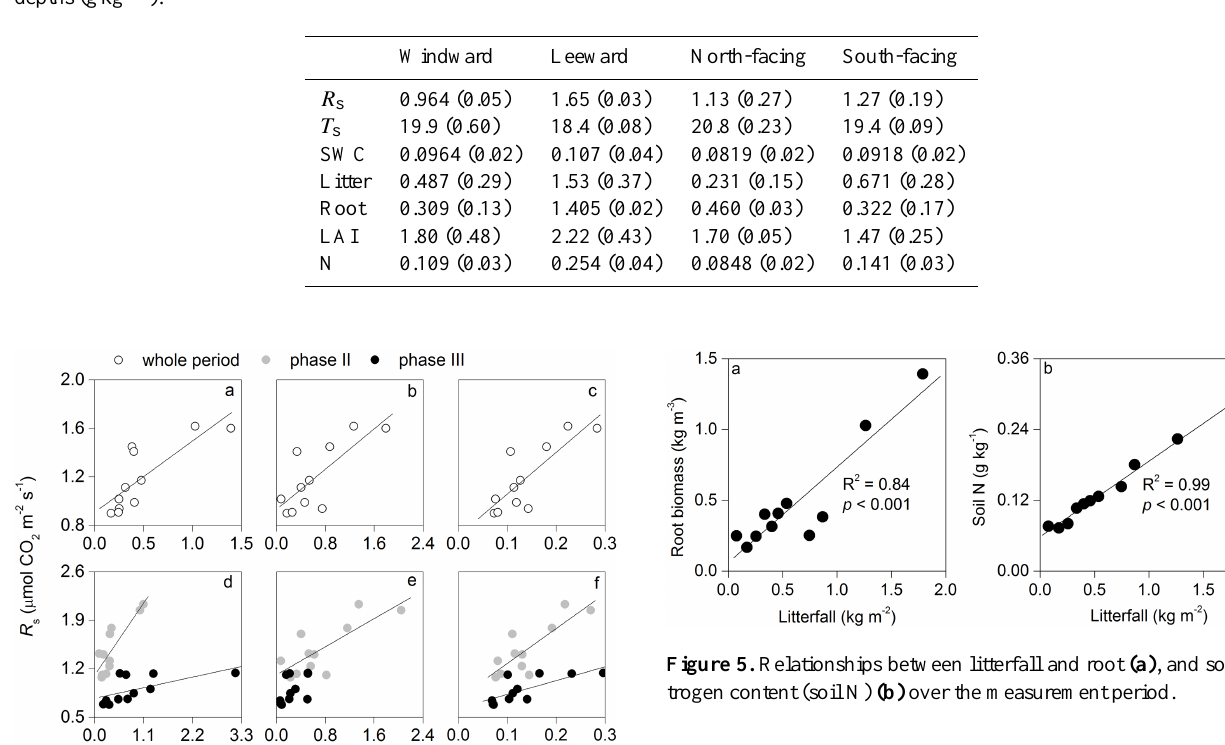
Table 2. Mean values (standard error in parentheses) of microhydrometeorological and plant-related factors on different slope orientations over the measurement period. R s : soil respiration (µmol CO 2 m − 2 s − 1 ); T s : soil temperature ( ◦ C); SWC: volumetric soil water content (m 3 m − 3 ); Litter: litterfall (kgm − 2 ); Root: root biomass (kgm − 3 ); LAI: leaf area index (m 2 m − 2 ); N: soil nitrogen content at 0–25cm soil depths (gkg − 1 ).